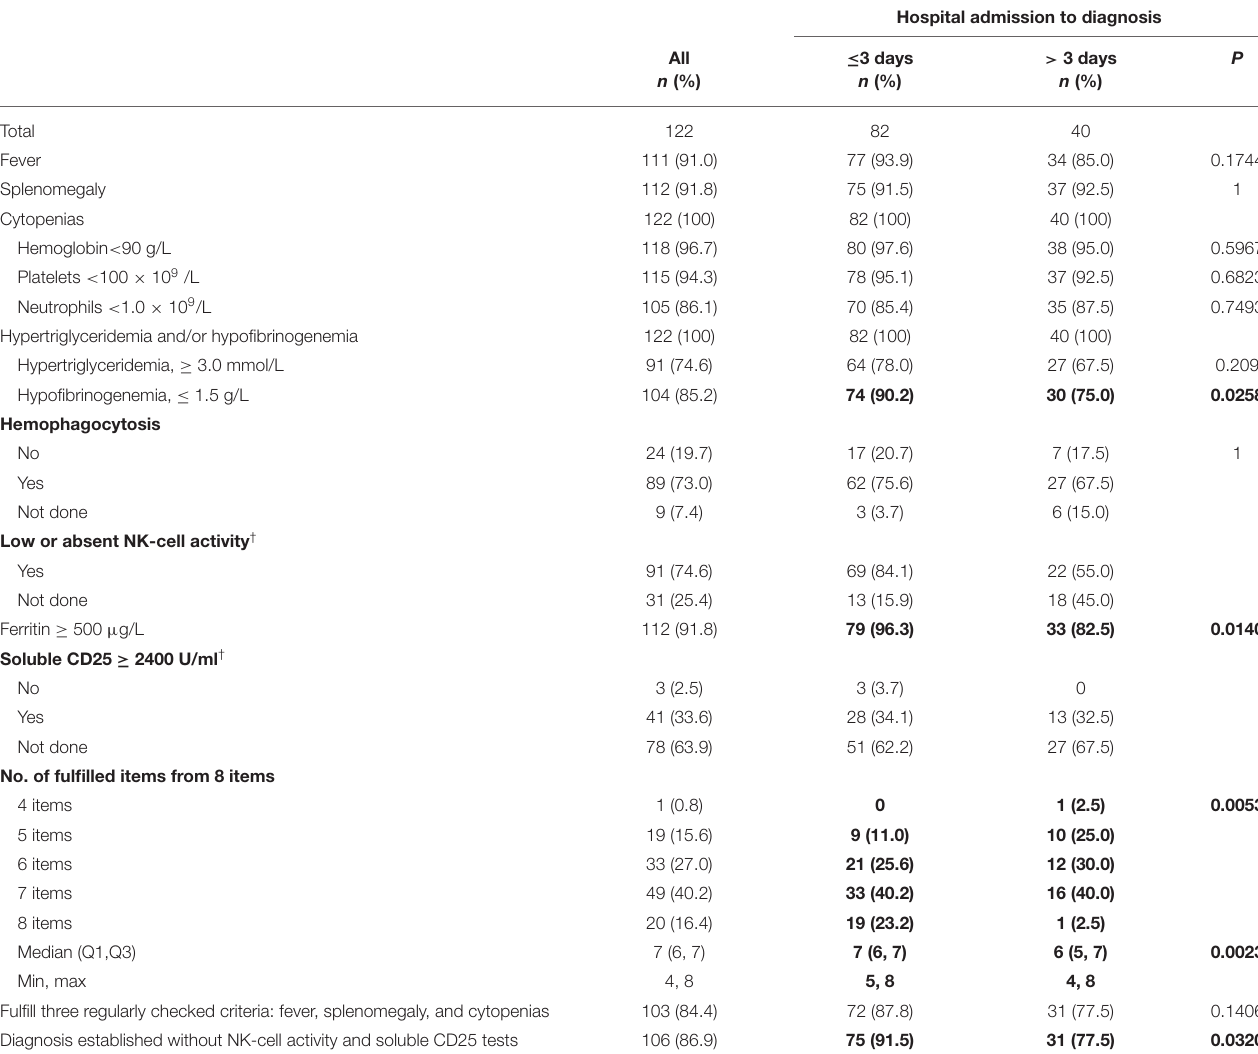
TABLE 2 | Fulfillment of the HLH-2004 diagnostic criteria during hospitalization according to HLH diagnostic time lag categories.